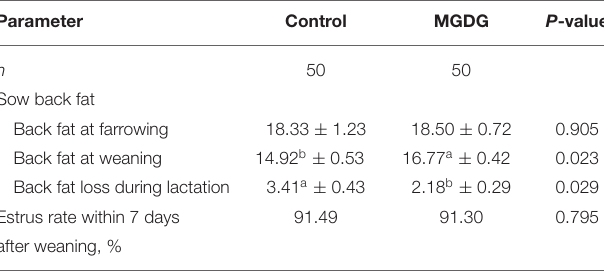
TABLE 6 | Effects of dietary MGDG supplementation during late gestation and lactation on immunoglobulin levels in sow colostrum and milk. Parameter